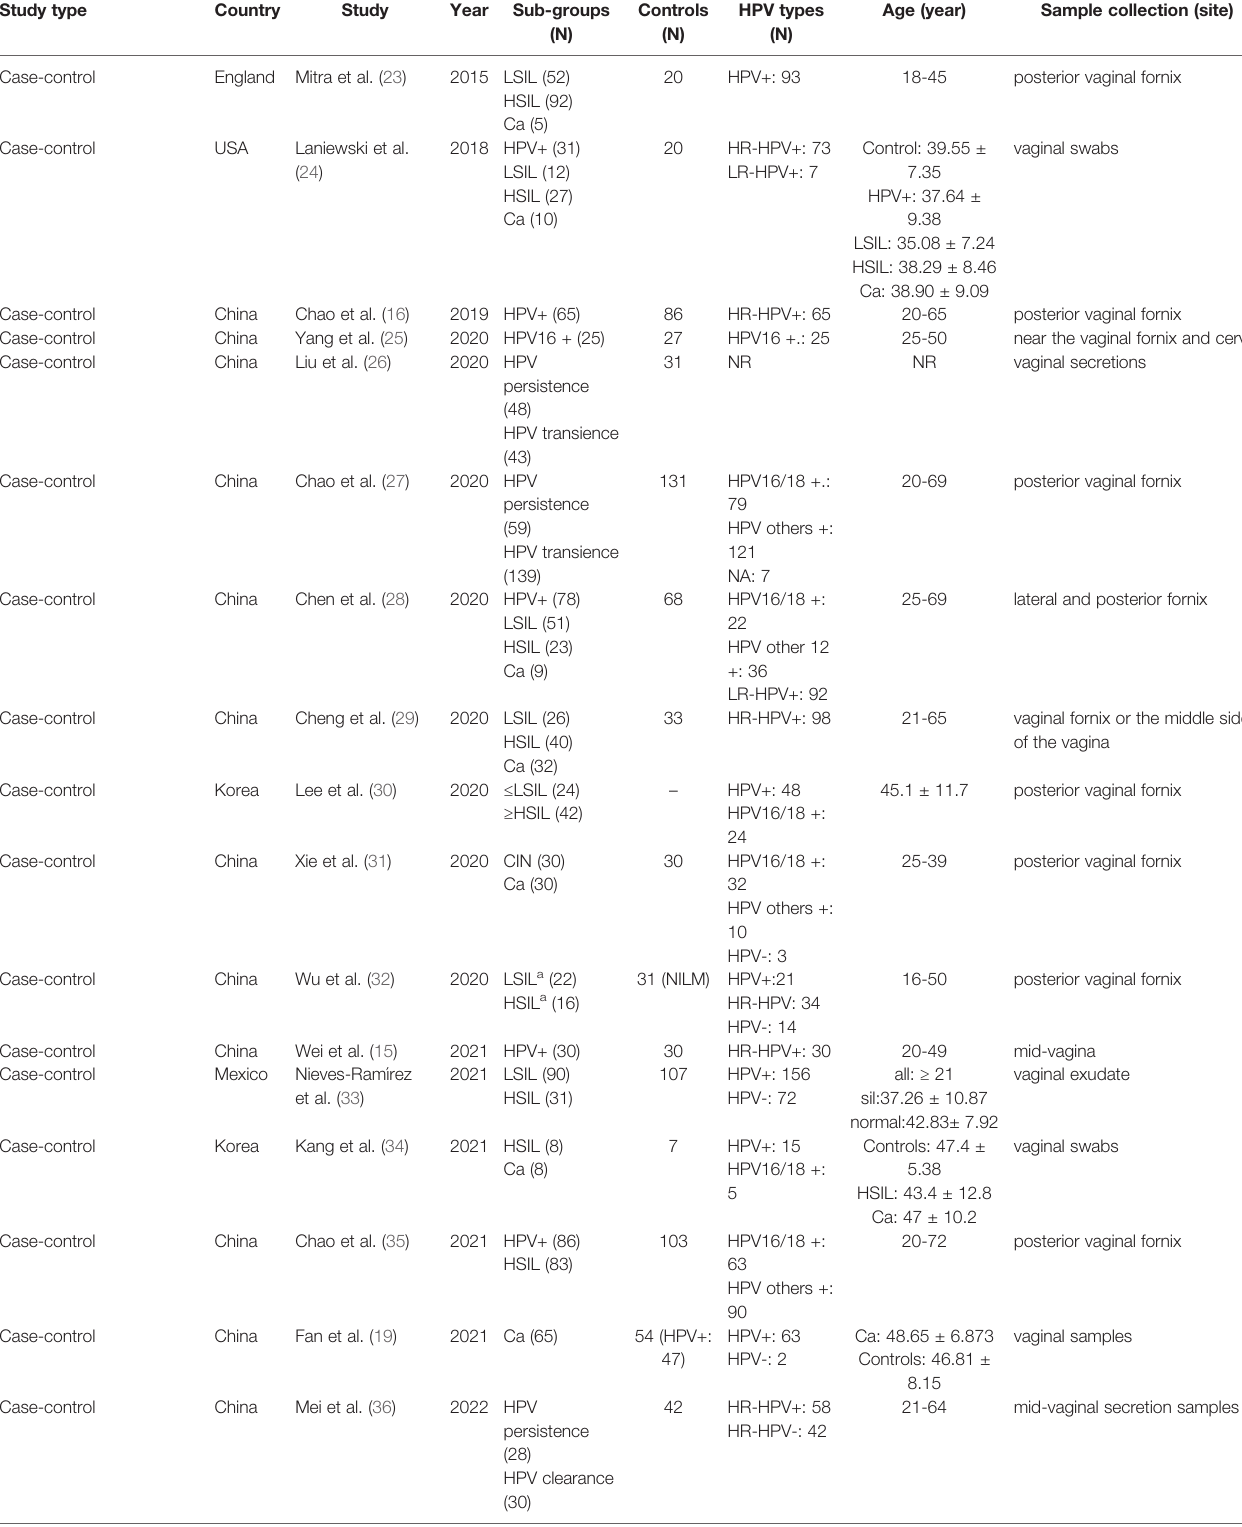
TABLE 1 | Characteristics of the included